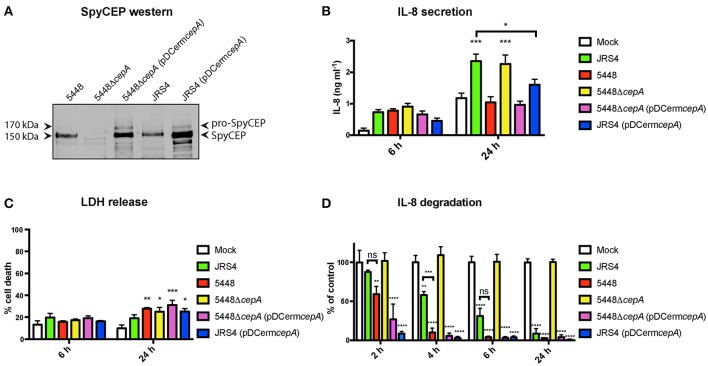
SpyCEP expression by 5448 results in reduced IL-8 secretion by TEpi cells during GAS intracellular infection. (A) Western blot analysis of cell wall extracts for detection of SpyCEP. Equivalent protein concentrations were loaded for 5448, JRS4, and 5448ΔcepA (100 μg), whilst 5 μg was loaded for 5448ΔcepA (pDCermcepA) and JRS4 (pDCermcepA). (B) IL-8 present in supernatants due to secretion by TEpi cells following GAS intracellular infection at 6 and 24 h post-infection, measured by ELISA. (C) Cell death measured by percentage of LDH released from TEpi cells at 6 and 24 h post-infection. (D) GAS strains were incubated with recombinant IL-8 at 37°C. SpyCEP activity correlates with IL-8 degradation as assessed by ELISA. For (B–D), data are plotted as the mean ± s.e.m. and represent three independent experiments performed in triplicate and analyzed by two-way ANOVA with Tukey's post-test. Significance shown is relative to mock at each timepoint, unless otherwise indicated. *P < 0.05; **P < 0.01; ***P < 0.001; ****P < 0.0001.